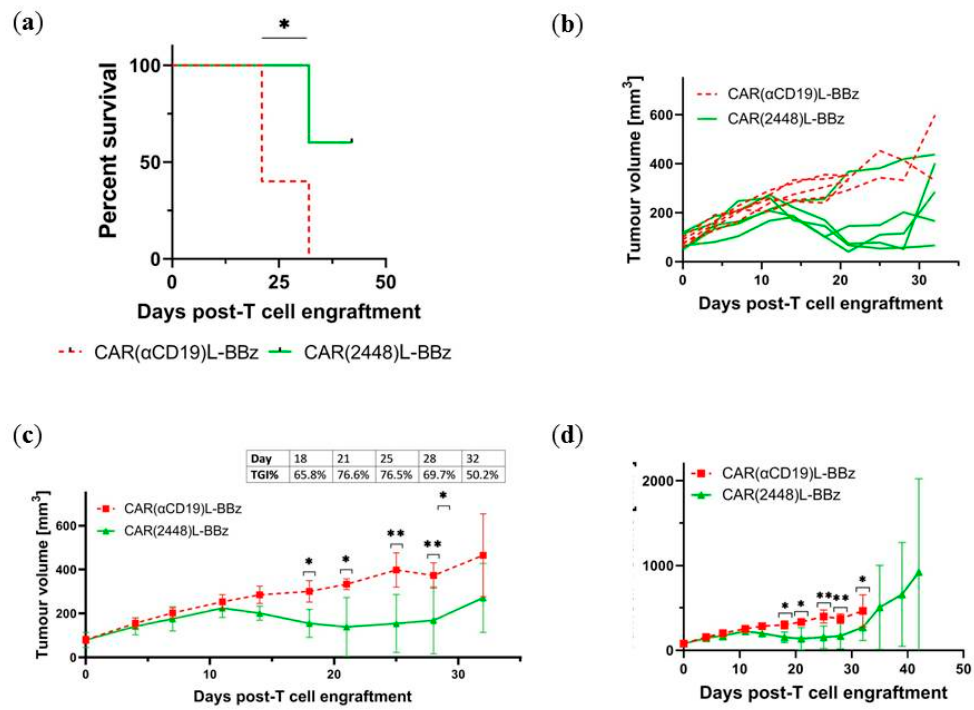
Figure 5. CAR(2448)L T cells mediate anti-tumour activity in vivo against ANXA2 + target cells. ( a ) Treatment with CAR(2448)L-BBz T cells confers a survival advantage on SKOV3 xenograft NIKO mice compared with control CAR( α CD19)L-BBz T cells. ( b ) CAR(2448)L-BBz T cells induce a reduction in tumour burden of SKOV3 xenograft NIKO mice compared to control CAR( α CD19)L-BBz T cells. ( n = 5 per group) ( c ) Mice treated with CAR(2448)L-BBz T cells have significant reductions in mean tumour burdens compared with mice treated with CAR( α CD19)L-BBz T cells. Maximal tumour growth inhibition is observed 3 weeks after CAR(2448)L-BBz T cell treatment. ( d ) Tumours of mice treated with CAR(2448)L-BBz T cells subsequently relapse. For all subfigures, abbreviations: TGI%—tumour growth inhibition ratio. * p < 0.05. ** p < 0.01.